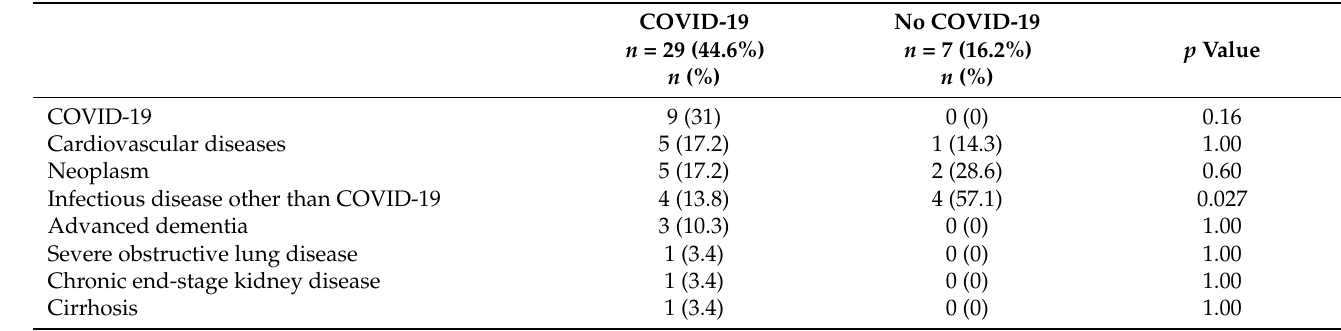
Table 3. Cause of death in patients with 65 nosocomial COVID-19 and 43 without nosocomial COVID-19.